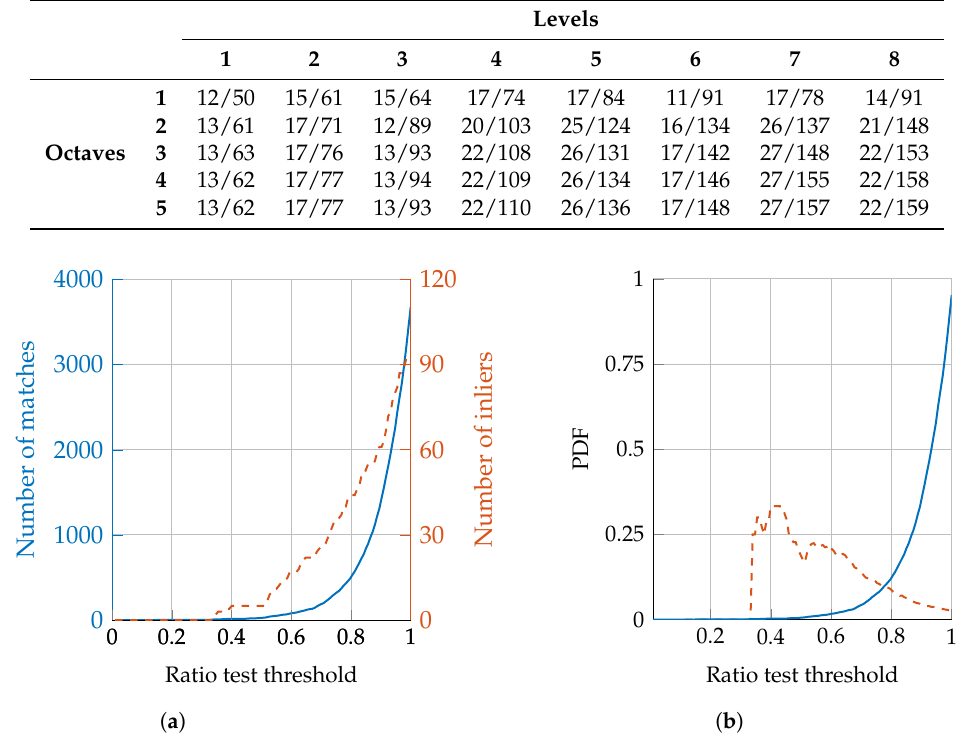
Figure 3. Influence of different ratio test thresholds for the Container dataset. ( a ) Number of remaining matches after applying the ratio test (solid) and the number of correct matches among them (dashed); ( b ) ratio of correct (dashed) and incorrect (solid)